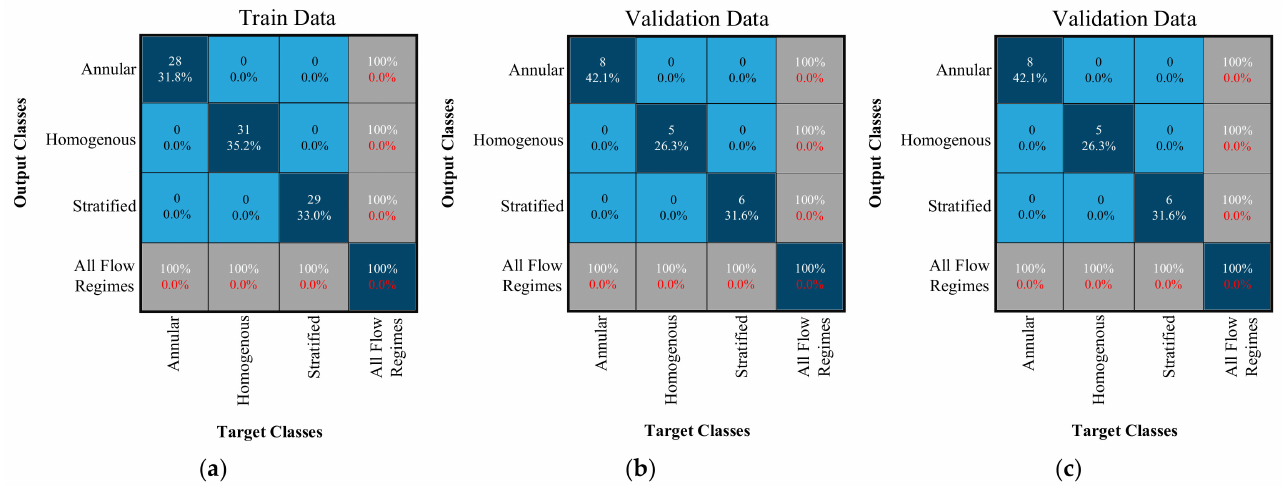
Figure 6. Confusion matrix to show the classification network performance for ( a ) training, ( b ) vali- dation and ( c ) testing